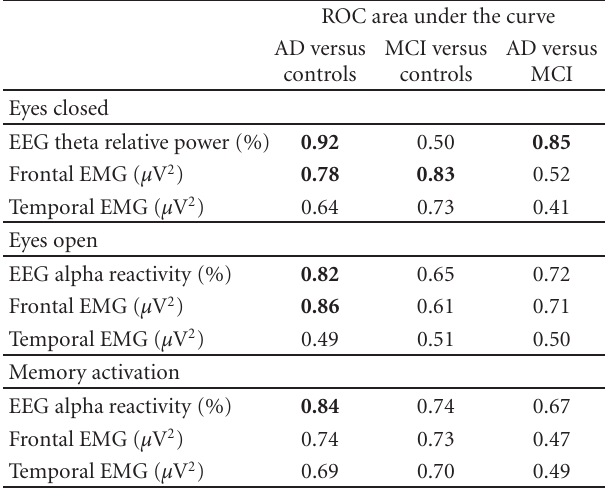
Table 4: Classification accuracy of EEG and EMG parameters by receiver operating curves (ROC).